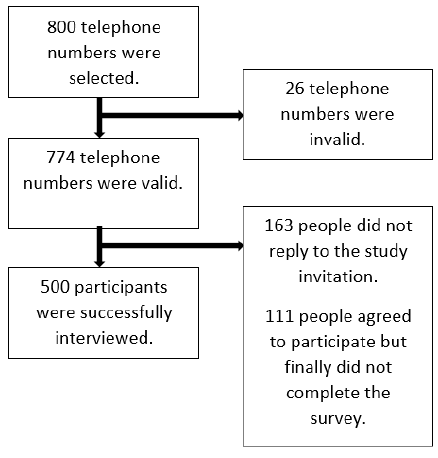
Figure 1. The flow diagram of recruitment.